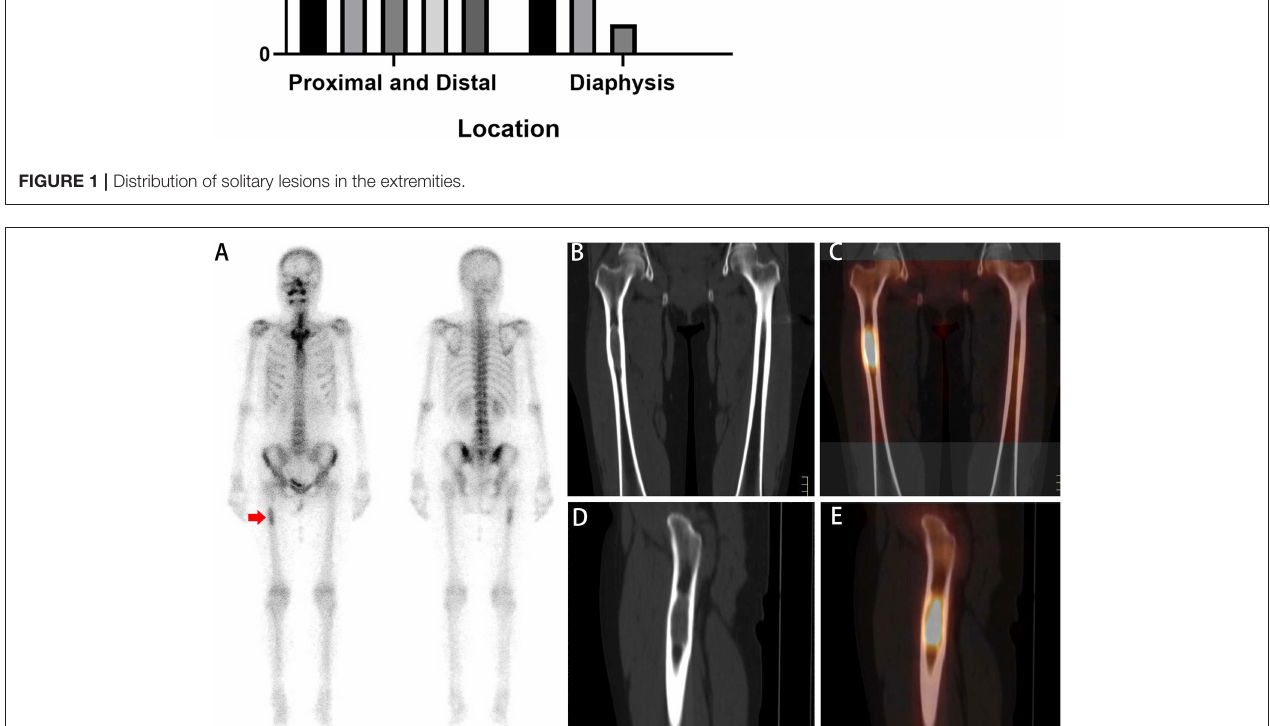
FIGURE 2 | A whole-body scan (A) revealed a focal area of low 99m Tc-MDP activity in the right femur (red arrow). No additional areas of abnormal 99m Tc-MDP uptake were identified in the remainder of the skeleton. Coronal (B,C) and sagittal (D,E) CT and SPECT/CT imaging showed focally increasing 99m Tc-MDP uptake corresponding to lytic changes and soft tissue masses in the diaphysis of the femur. A biopsy was subsequently performed, and pathologic analysis confirmed the diagnosis of bone metastasis.